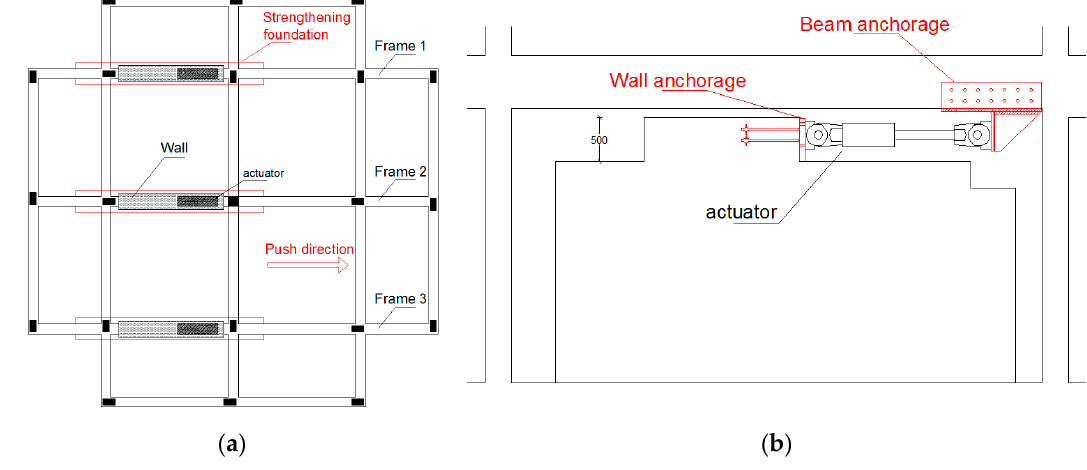
Figure 1. Test setup: Top view ( a ) and front view ( b ).